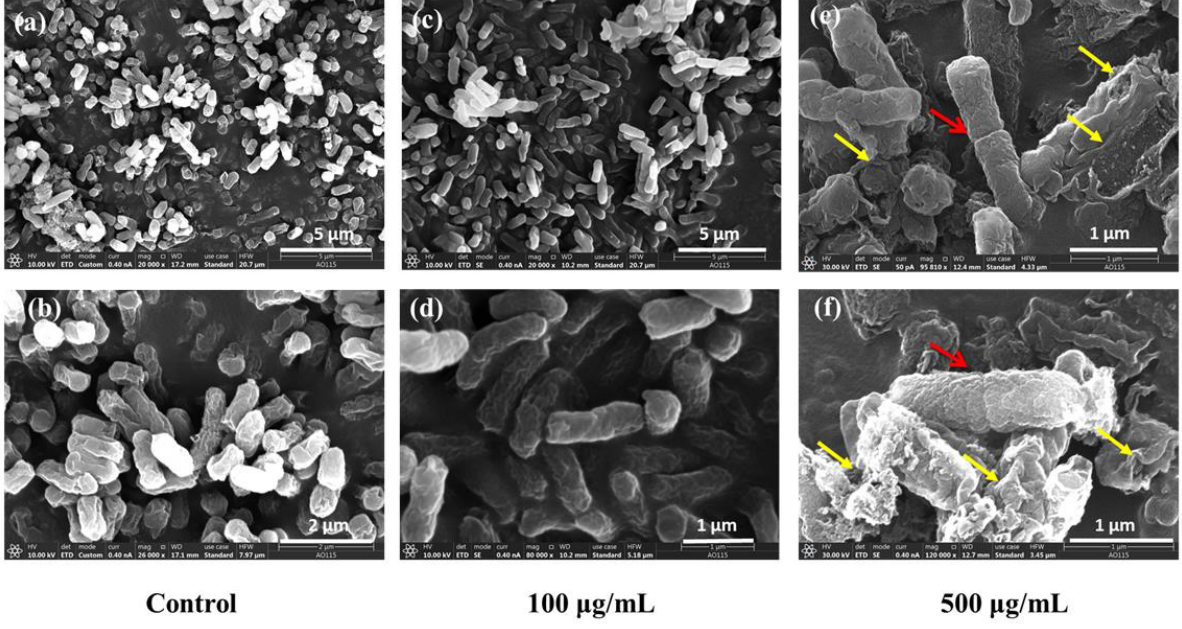
Figure 7. SEM image of E. coli . ( a ) and ( b ) Control group, ( c ) and ( d ) 100 µ g/mL, ( e ) and ( f ) 500 µ g/mL. As shown in Figure 8a,b, the cells in the blank group had normal morphology and a complete internal structure, with the cell wall and cell membrane being closely attached. In Figure 8c–f, some CQDs are shown adhering to the cell membrane and entering the cell interior (as indicated by the red arrow). When the concentration of CQDs reached 200 µ g/mL, the cells became swollen and deformed, as indicated by the yellow arrows in Figure 8g,h. With the further increase of CQDs concentration, cell edema became more pronounced (Figure 8i,j), the cell membrane ruptured (as indicated by the green arrows in the figures), and cytoplasm flowed out (as indicated by the blue arrows), accompanied by a large number of dead cells (Figure 8k,l).